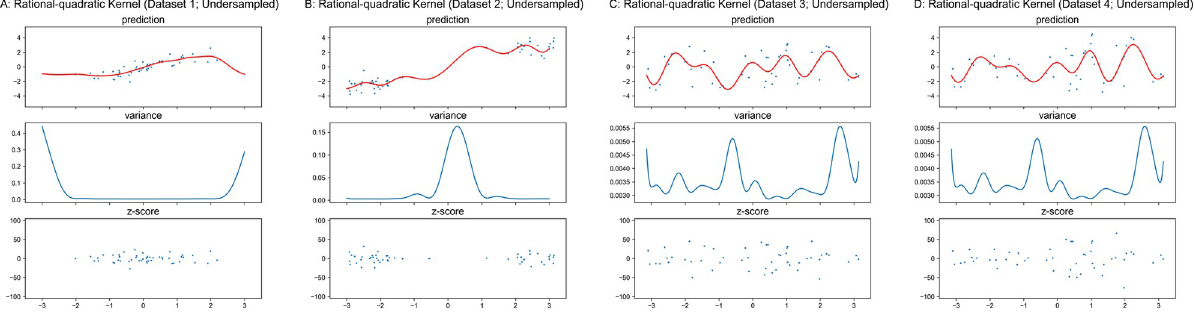
Fig 11. GPR with Rational-Quadratic kernel on undersampled datasets. Scales of Y-axis for variance plots are different.